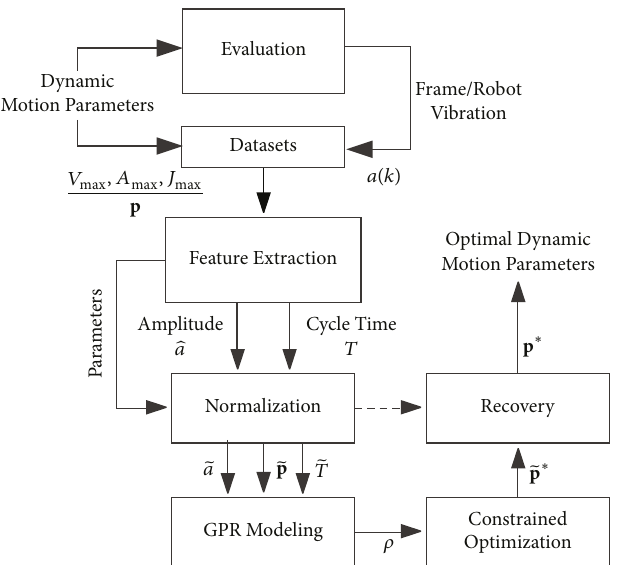
Figure 6: Diagram of the signal processing, modeling, and optimization